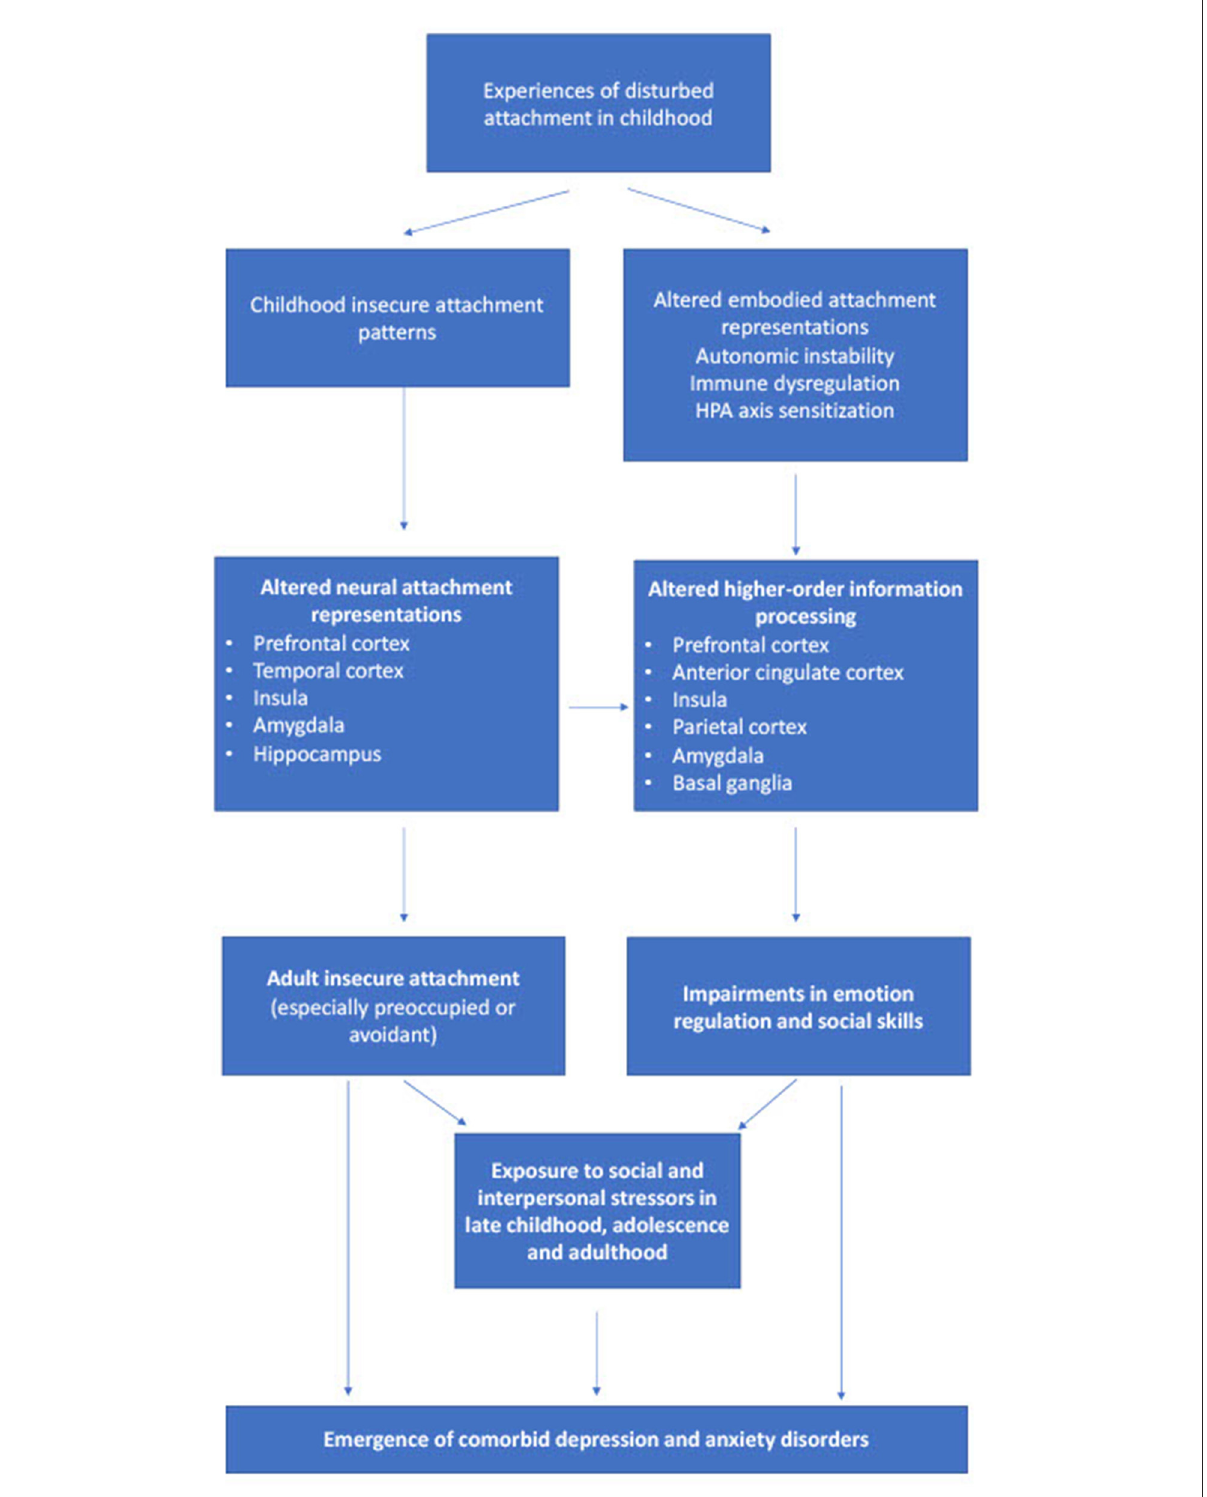
FIGURE2 Processes by which insecure attachment to a caregiver in early childhood can contribute to the development of comorbid depression and anxiety, and their neural correlates. HPA,